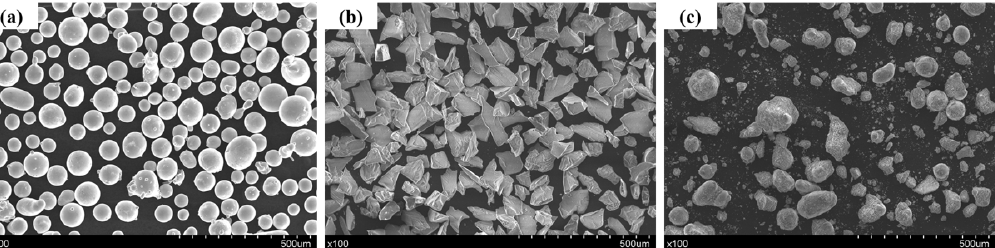
Figure 1. SEM images of powder: ( a ) Fe901 powder; ( b ) Al 2 O 3 powder; ( c ) Fe901/Al 2 O 3 mixed powder.